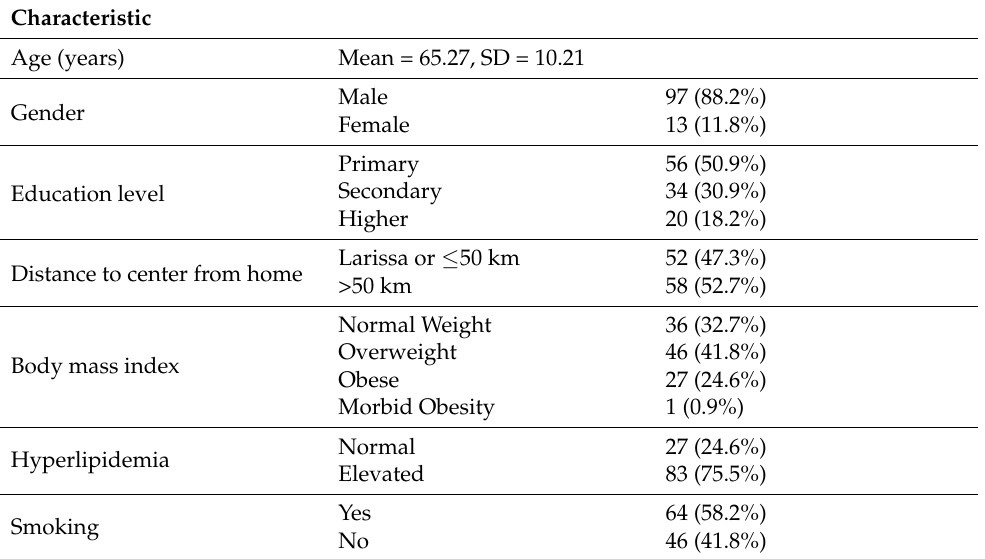
Table 2. Characteristics of participants included in the study, N = 110.